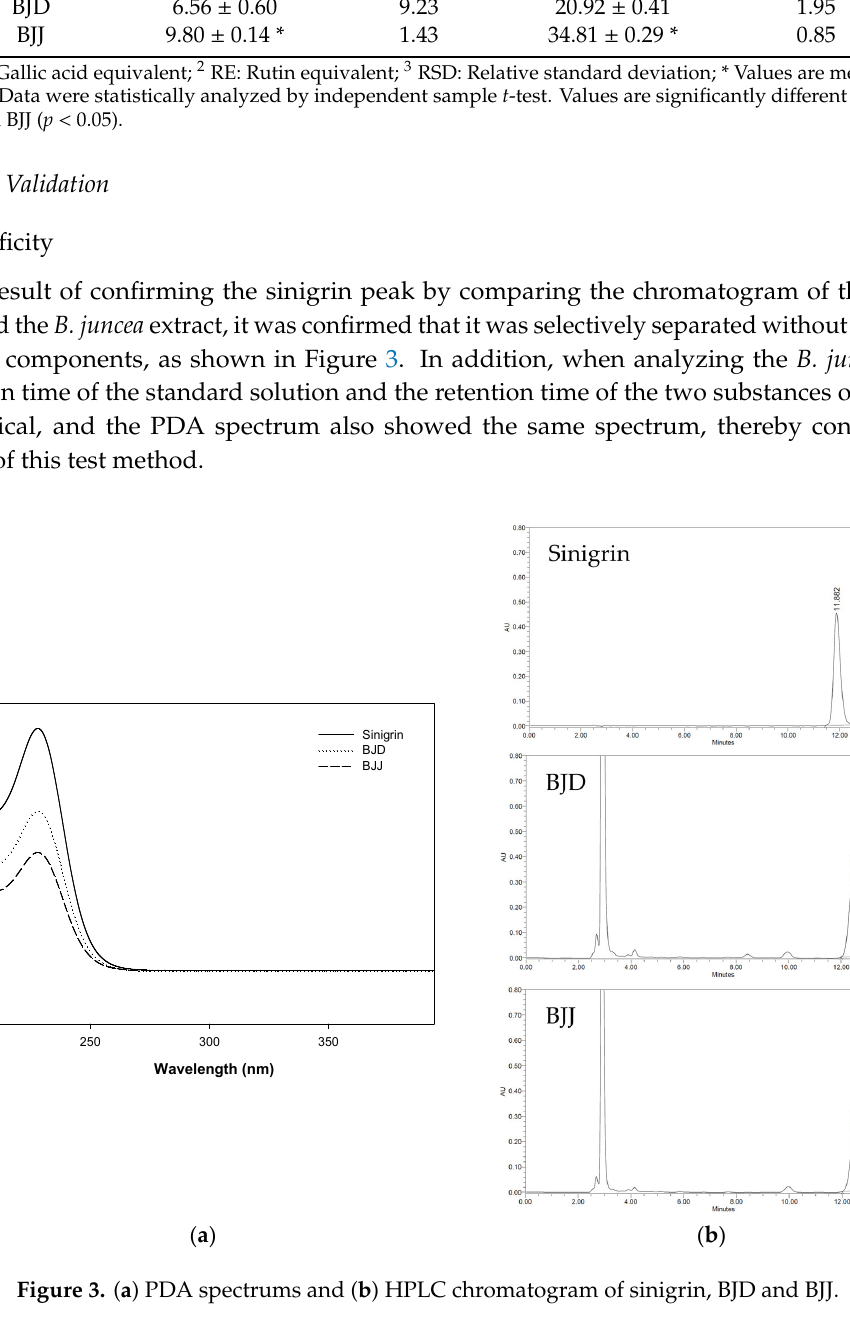
Table 4. Total phenol and total flavonoid contents of BJD and BJJ. Sample